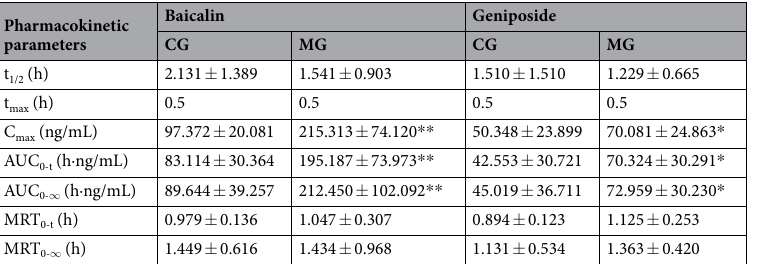
Table 1. Pharmacokinetic parameters of baicalin and geniposide in CG and MG rats after intravenous administration of QKLI. * p < 0.05, ** p < 0.01, compared with CG